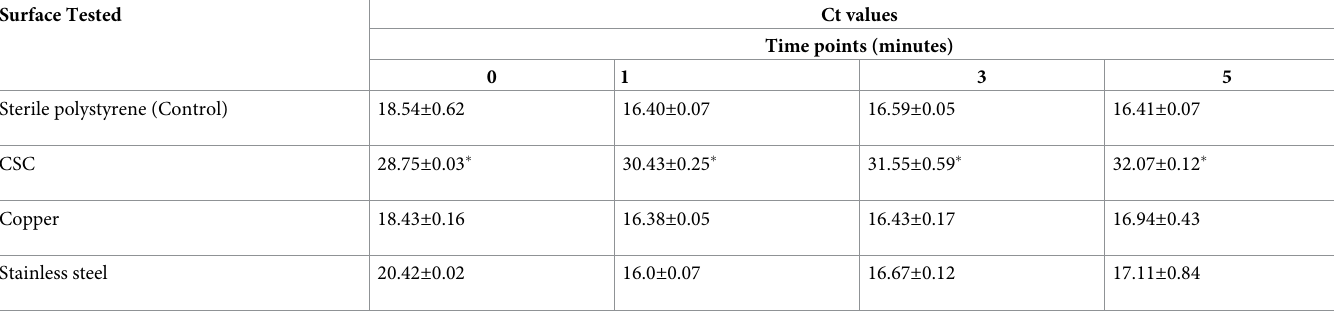
Results are represented as means of replicates ± SD between the replicates.